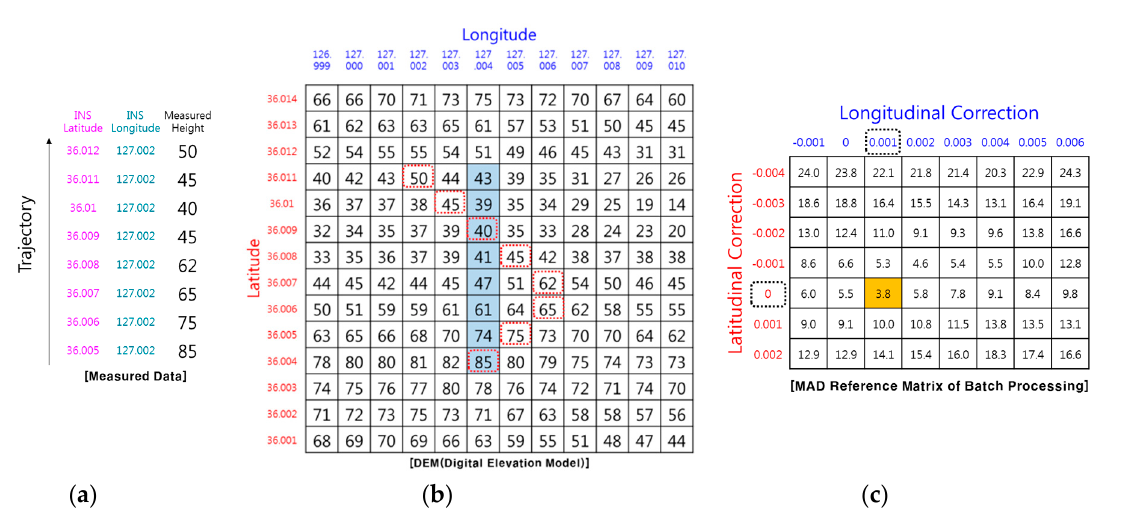
Figure 4. Example of TRN using RA (real case): ( a ) Measured terrain profile; ( b ) DEM; ( c ) position correction value